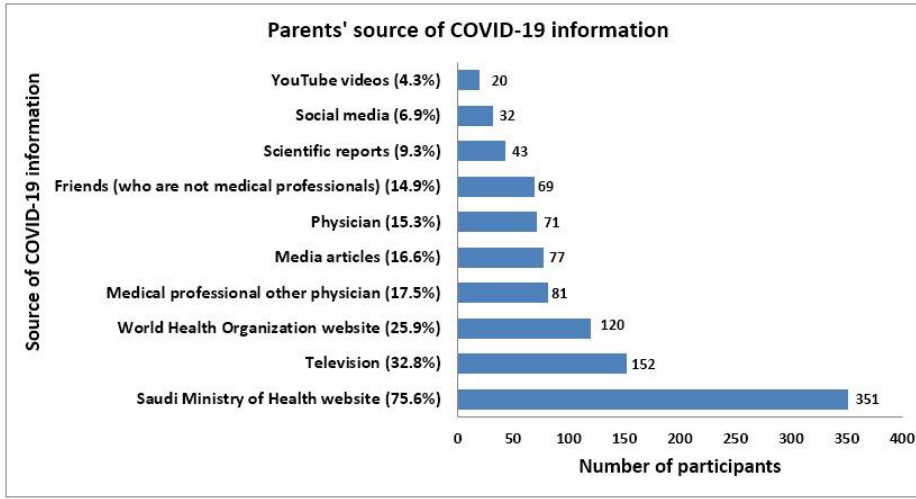
Figure 3. Parent’s sources of COVID -19 information.